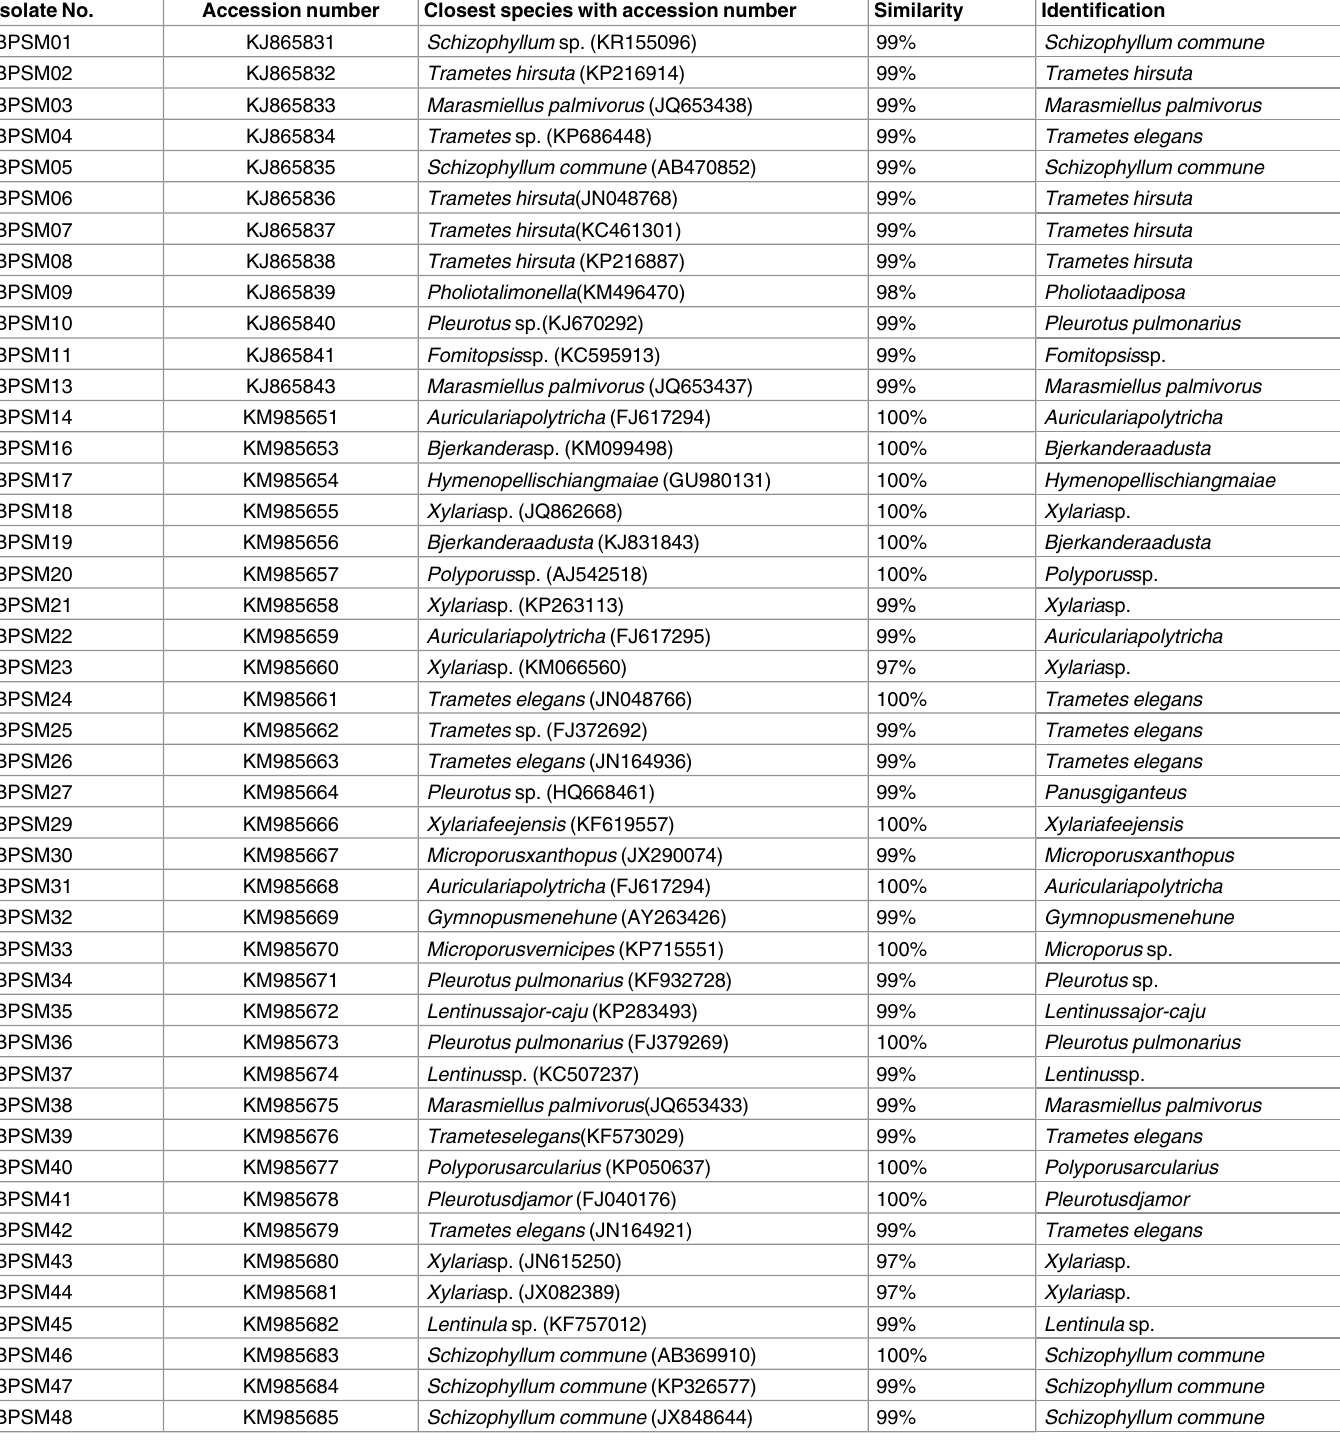
Table 3. Identification of antagonistic wild mushrooms based on ITS rRNA gene sequences. Isolate